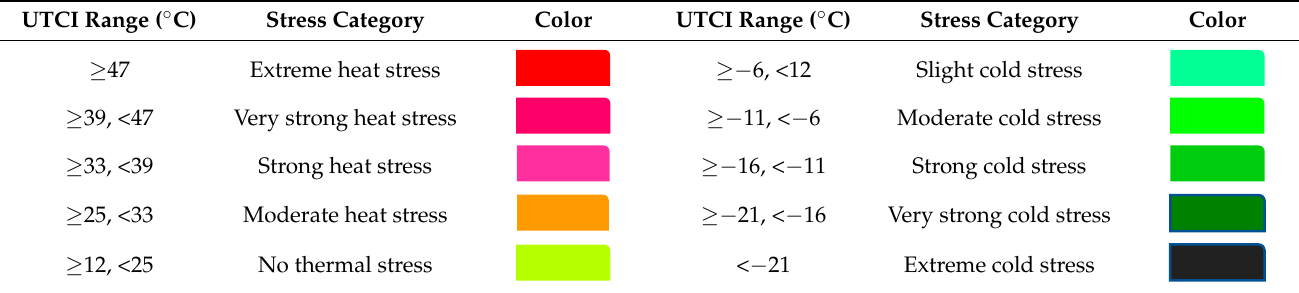
Table 1. UTCI assessment scale (Adapted from Ref. [46]).